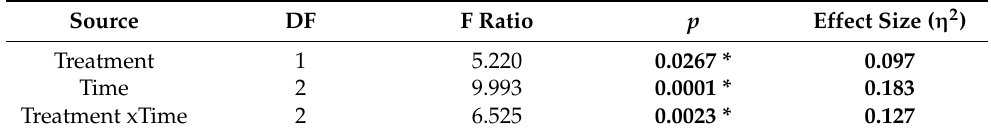
Table 4. Repeated measures ANOVA results for the Intrinsic Motivation Inventory subscale interest and enjoyment.